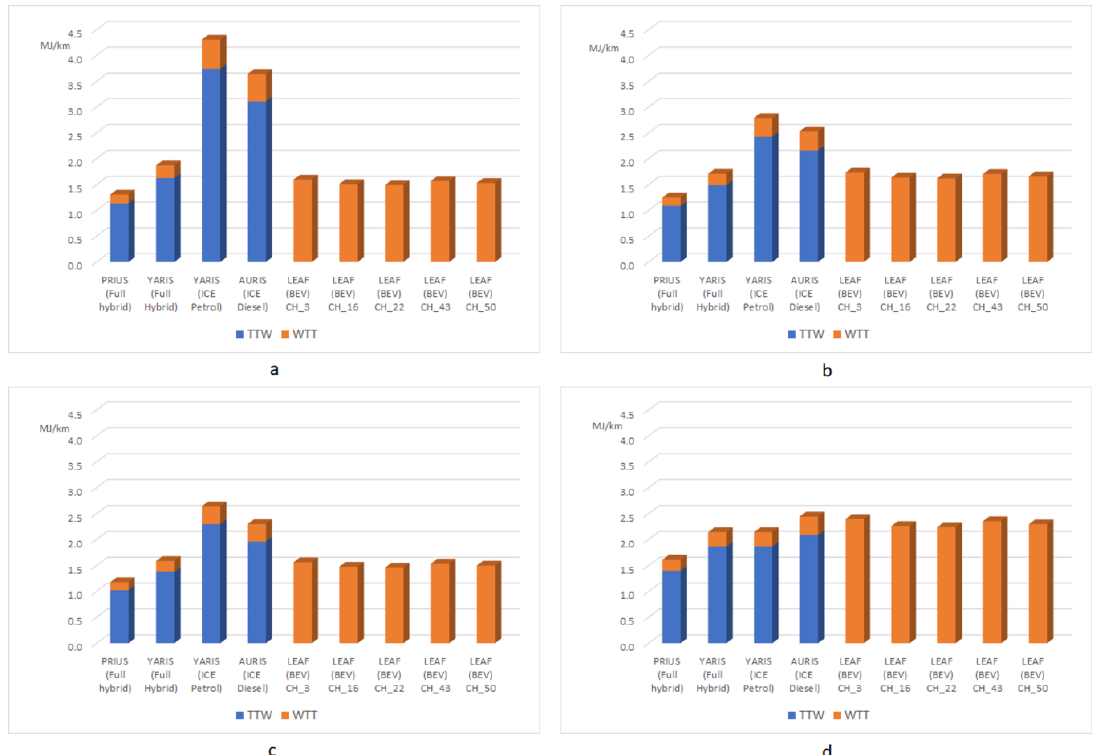
Figure 10. Non-renewable energy consumption of the vehicle analyzed in urban roads with high traffic density ( a ), urban low traffic intensity ( b ), extra-urban ( c ), and motorway ( d ).